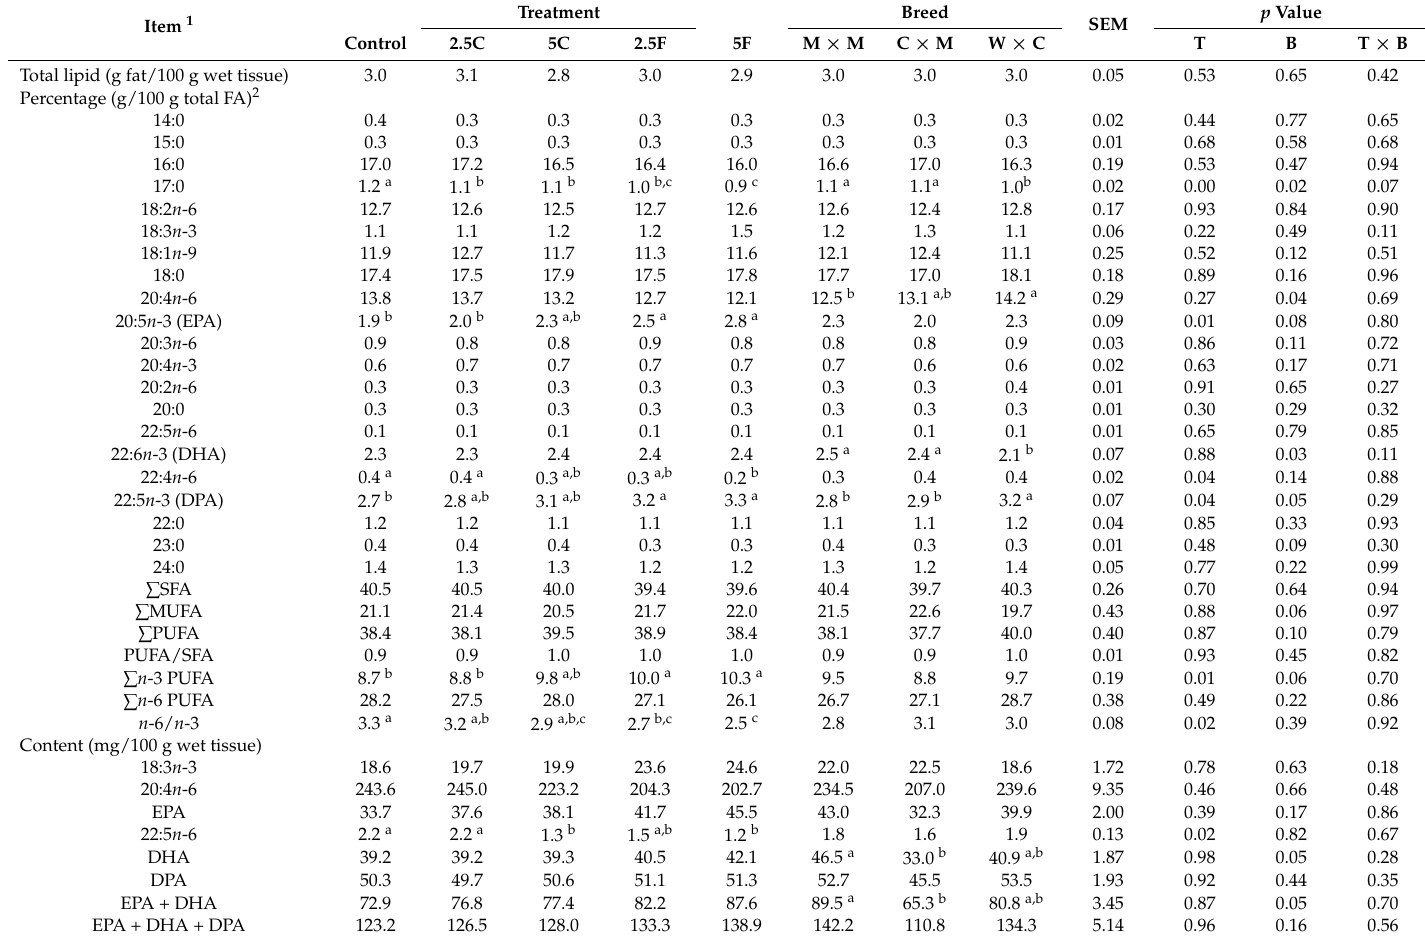
Table 4. Variation in kidney fatty acid profile of prime lambs as influenced by omega–3 oil supplementation and